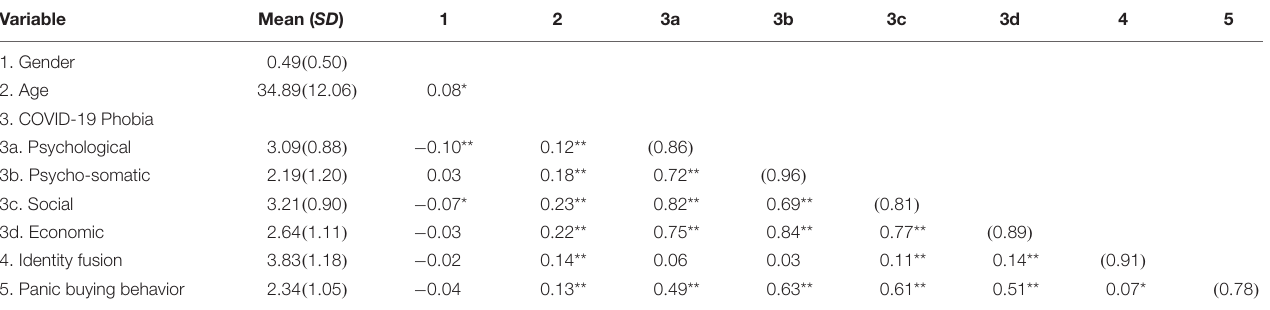
TABLE 2 | Descriptive statistics and correlations across the three countries ( N = 734). Variable Mean ( SD